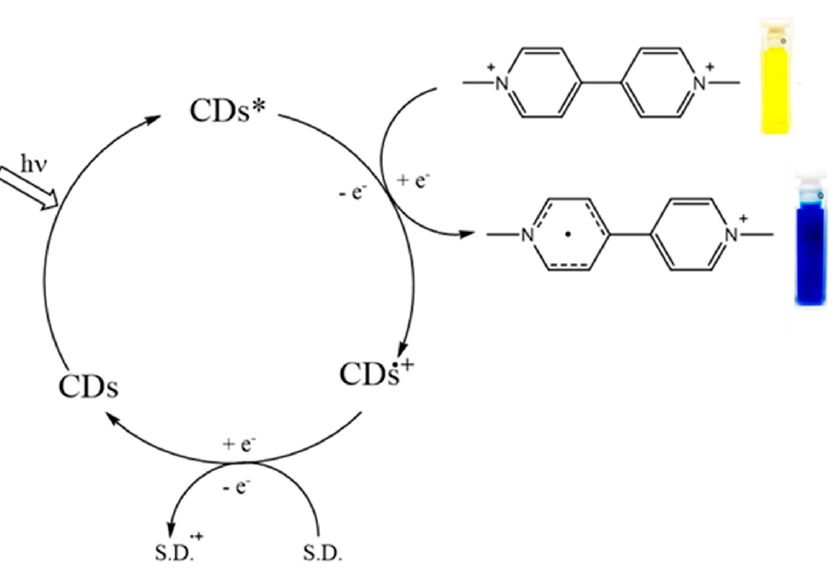
Figure 6. Catalytic scheme for the single electron photoreduction of methyl viologen with carbon dots (CDs).